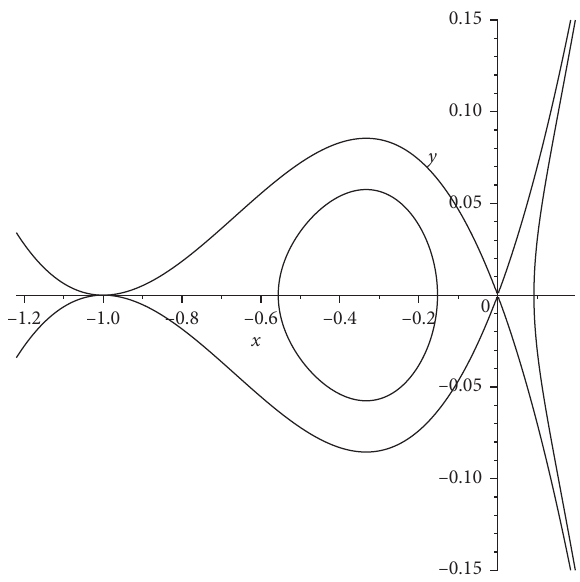
Figure 1: The level set of H ( x, y )